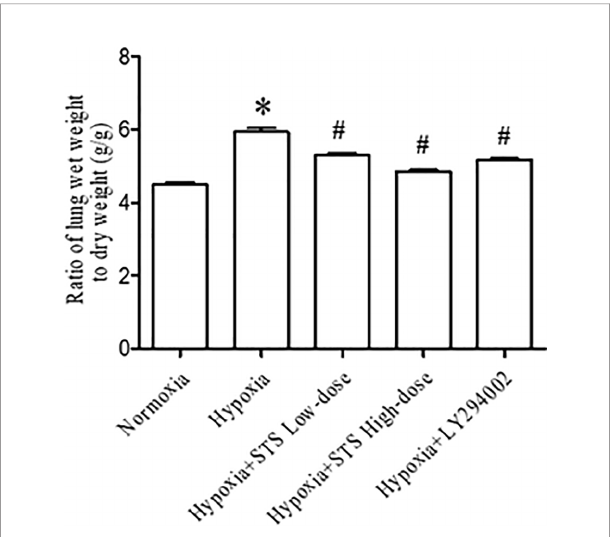
FIGURE 3 | Ratio of lung wet weight to dry weight for each group. Data are presented as mean ± SEM (n = 6). * P < 0.05 compared with normoxia group, # P < 0.05, compared with hypoxia